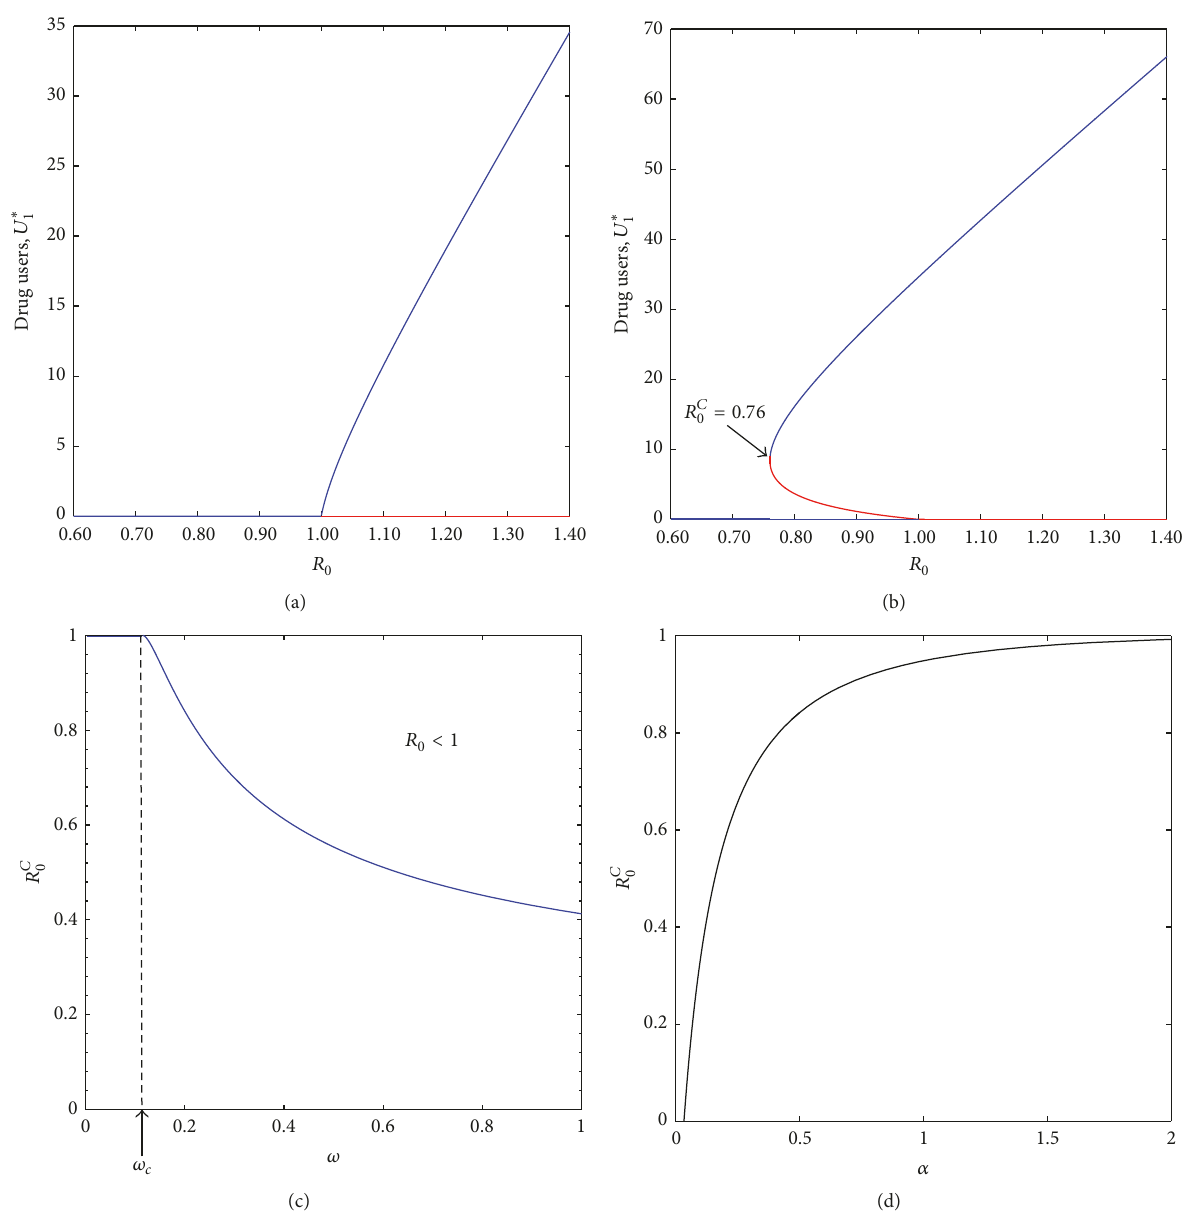
Figure 3: (a) and (b) represent bifurcations where drug users, 𝑈 ∗ 1 , not in treatment equilibrium are plotted as a function of 𝑅 0 . The blue solid line represents the stable equilibrium while the red solid line represents the unstable equilibrium. (a) represents forward bifurcation and the parameters used include 𝜔 = 0.11 < 𝜔 𝑐 = 0.1156 , 𝜇 = 0.01 , 𝛽 = 0.001 , 𝛿 1 = 0.002 , 𝛿 2 = 0.001 , 𝜉 = 0.015 , 𝛼 = 0.9 , 𝑝 = 0.467 , 𝜎 = 0.1 , and Λ ∈ {1, 3} while (b) represents backward bifurcation and parameters used are the same as in (a) except 𝜔 = 0.25 > 𝜔 the critical value 𝑅 𝐶 0 as a function of saturation parameter 𝜔. The black dotted line represents the threshold 𝜔 𝑐 which if exceeded gives rise to backward bifurcation. (d) depicts the critical value 𝑅 𝐶 0 as a function of treatment rate 𝛼